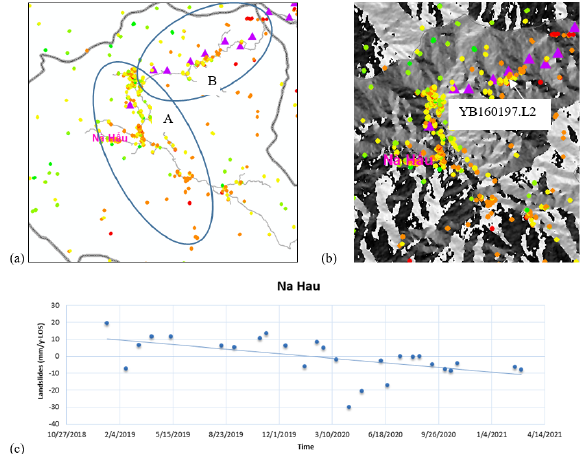
Figure 10. (a) Distribution of permanent scatter points showing landslide rate, (b) the positions of PS points matched with survey point in Na Hau commune are superimposed on aspect map, (c) the chart of landslide point selected from (b).